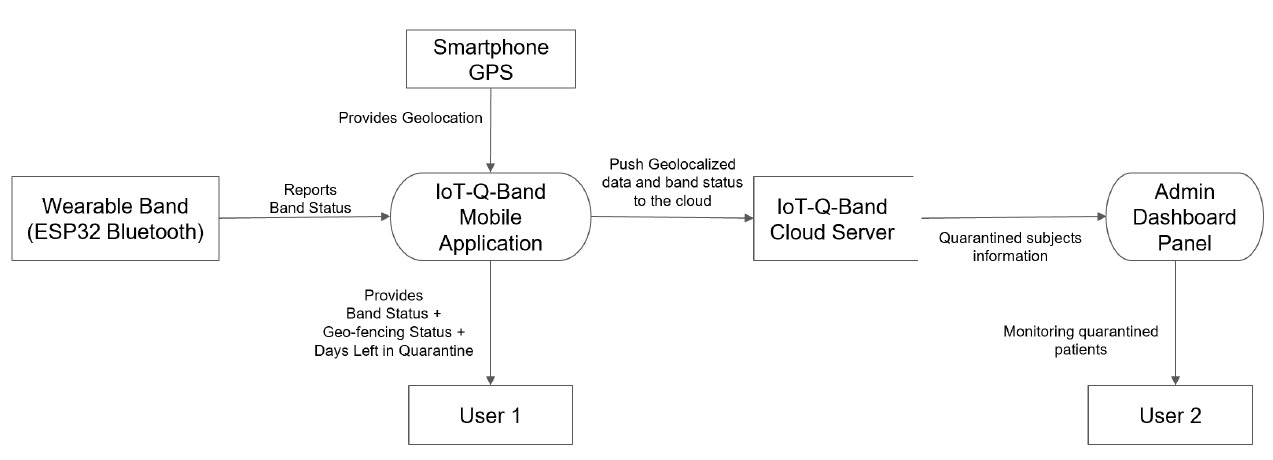
Figure 2. Data flow diagram of the IoT-Q-Band system. In this diagram, User 1 is a person wearing the IoT-Q-Band, and User 2 is a person/authority monitoring the quarantined